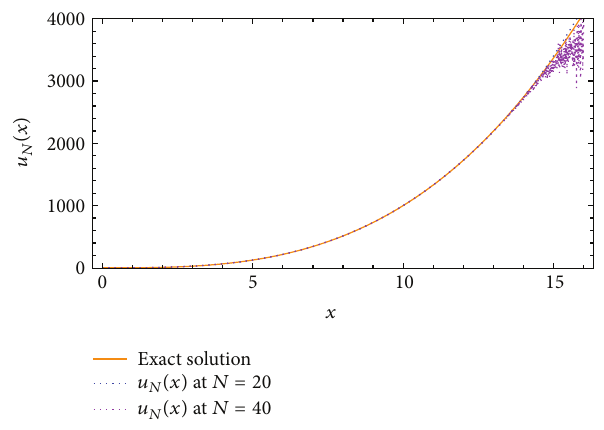
Figure 3: Comparing the exact and approximate solutions at 𝑁 = 20 , 40, with 𝛼 = 0 and 𝛽 = 2